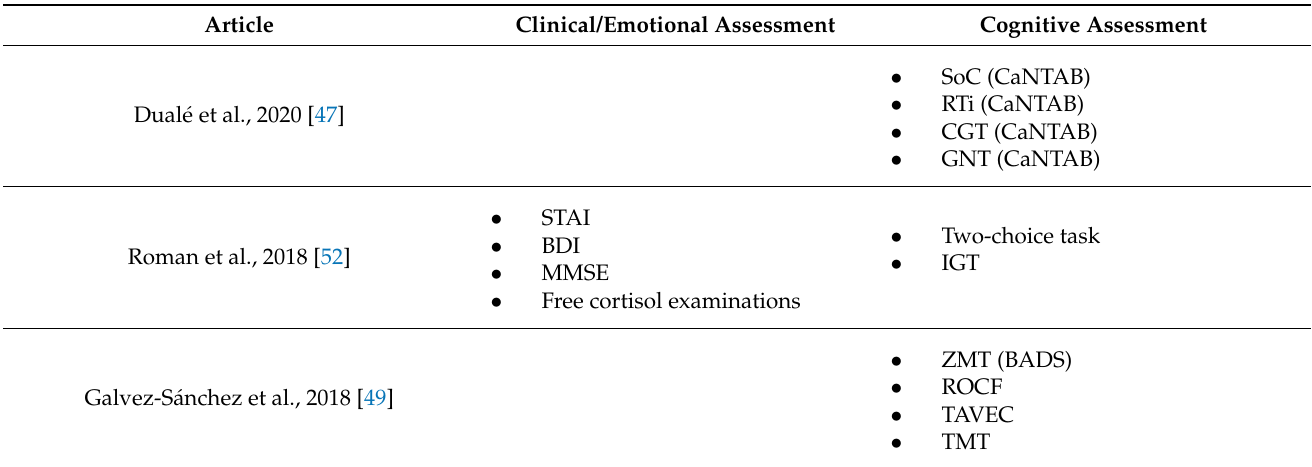
Table 3. Clinical/emotional and cognitive assessment. Standardized batteries from which tests were derived are indicated in